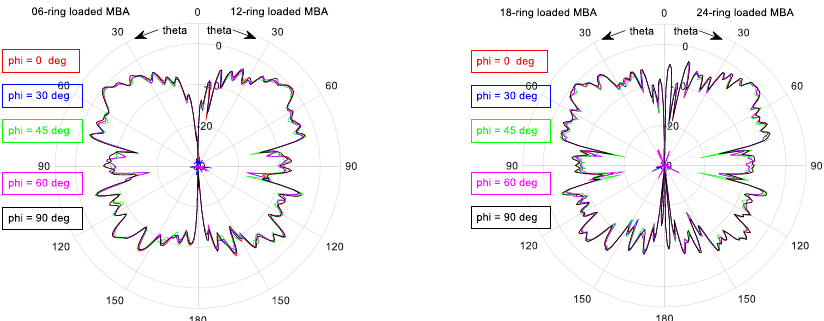
Figure A8. 2D patterns at 47 GHz of 6-, 12-, 18- and 24-ring-loaded MBA in different cutting planes.